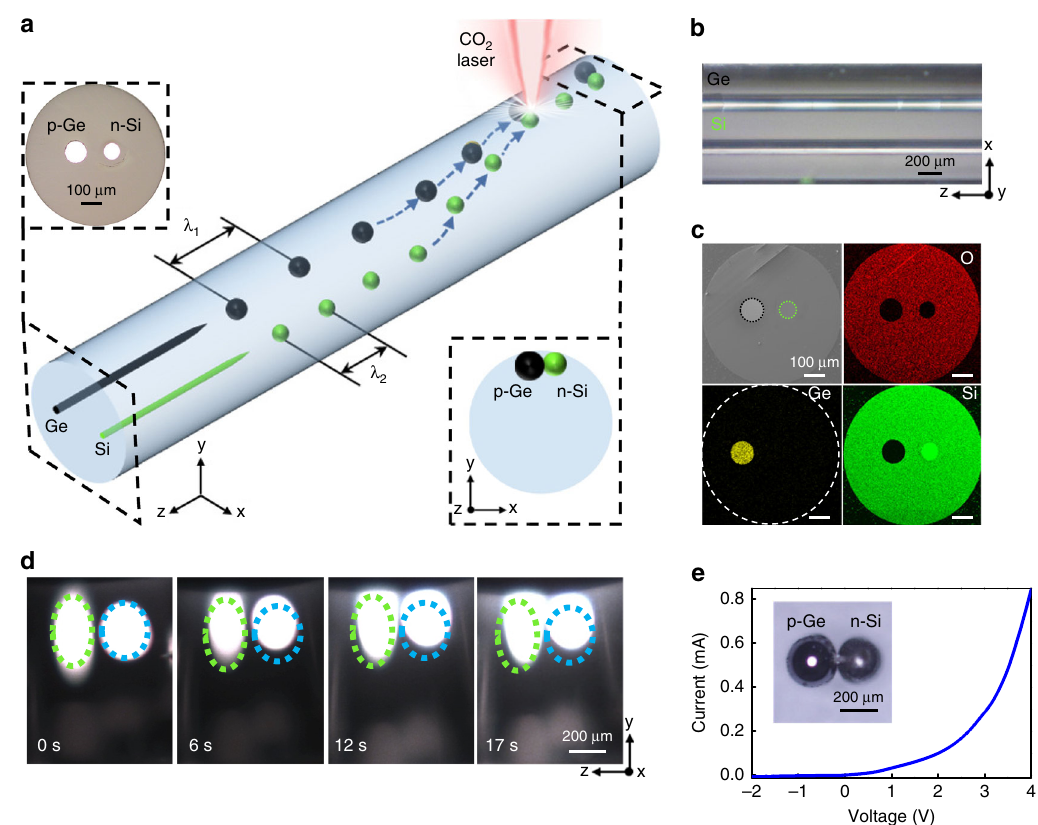
Fig. 5 Fabrication of in- fi bre p-type germanium n-type silicon heterojunction molecules based on the CO 2 laser induced thermocapillary convection. a Schematic of the asynchronous break-up of a p-type germanium and n-type silicon dual-core fi bre and in- fi bre structure reconstruction based on the CO 2 laser induced thermocapillary convection for p-n heterojunction molecules fabrication. Due to the different viscosities, melting points and core diameters, the periods of particle chain of germanium and silicon are different ( λ 1 for germanium and λ 2 for silicon). b Microscope image of p-type germanium and n- type silicon dual-core fi bre. c The EDS mapping of the polised cross-section of p-type germanium and n-type silicon dual-core fi bre. d Snapshots of in- fi bre Ge/Si particles manipulated by the CO 2 laser power at different time-points. At the beginning ( t = 0 s), the p- and n-type particles are located at the right and left of the laser beam. Starting from the laser switched on, the particles are dragged, migrated towards the laser beam and eventually contact with each other to form a p-n molecule ( t = 17 s). The particles show in elliptical shape due to the convex lens effect of the cylindrical silica cladding. The actual spheres are in spherical shape. e I – V characteristic of the dual-sphere p-n germanium-silicon heterojunction molecule. The inset show the contacted pGe- nSi junction molecule after